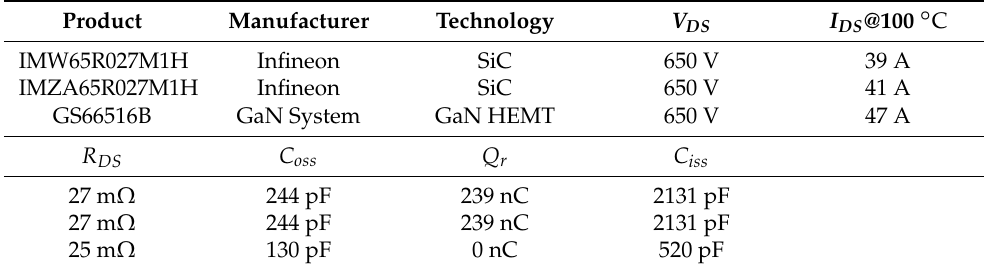
Table 2. Commercial WBG power devices potentially suitable for the